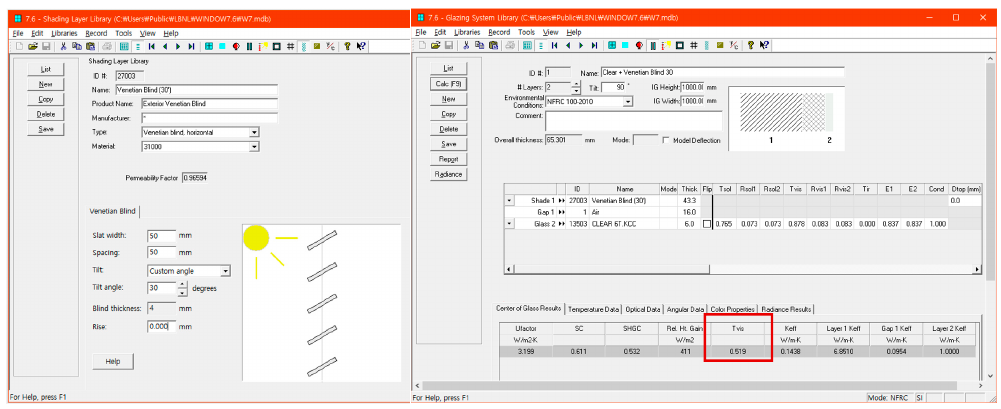
Figure 19. Calculation of visible light transmittance of blind using LBNL’s Window 7.6 program.